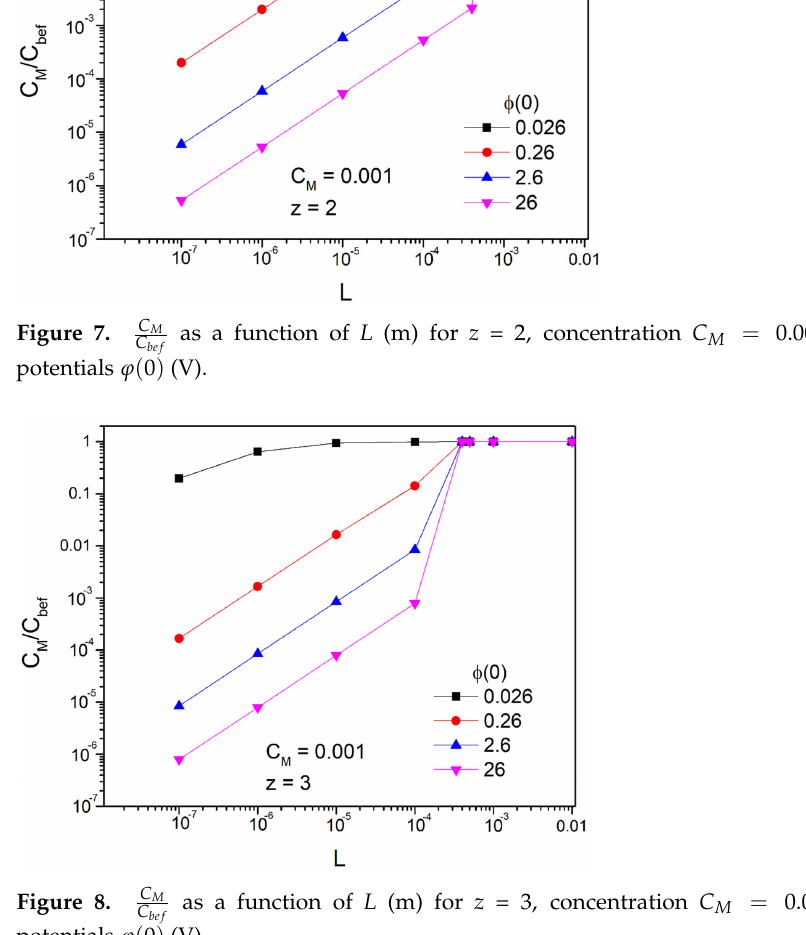
for various potentials (cid:2923) (cid:3119)